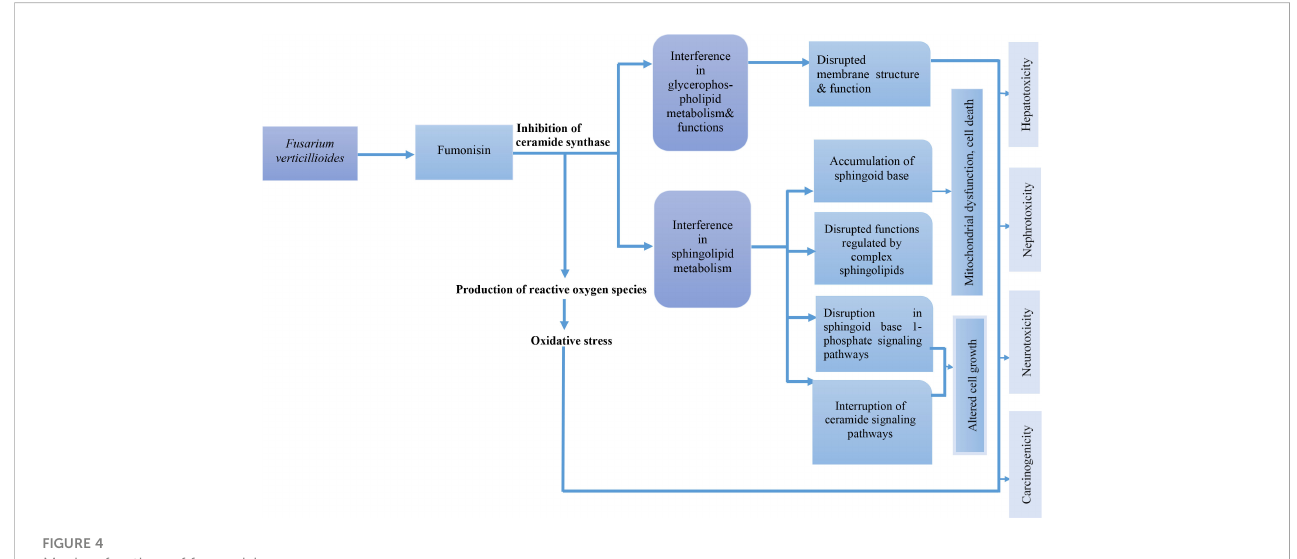
FIGURE 4 Mode of action of